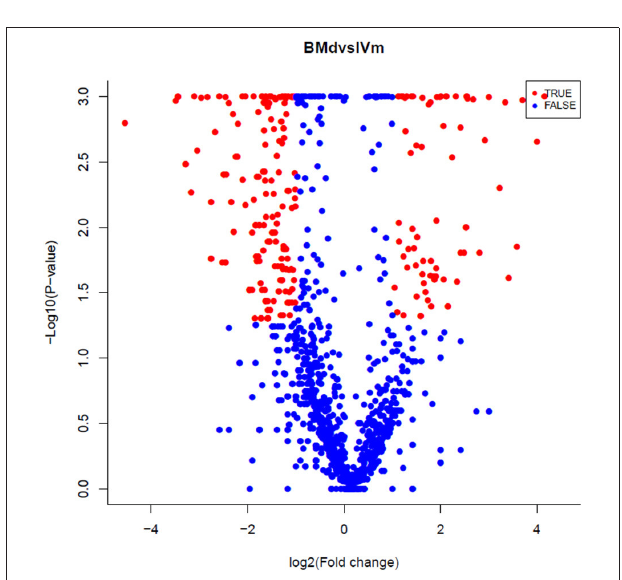
FIGURE 3 | A volcano plot of the differentially expressed miRNAs in the apple twig bark challenged with V. mali compared with the mock control. For each miRNA, sequence reads were divided by the total sequence number, then multiplied by 1,000,000 (reads per million).